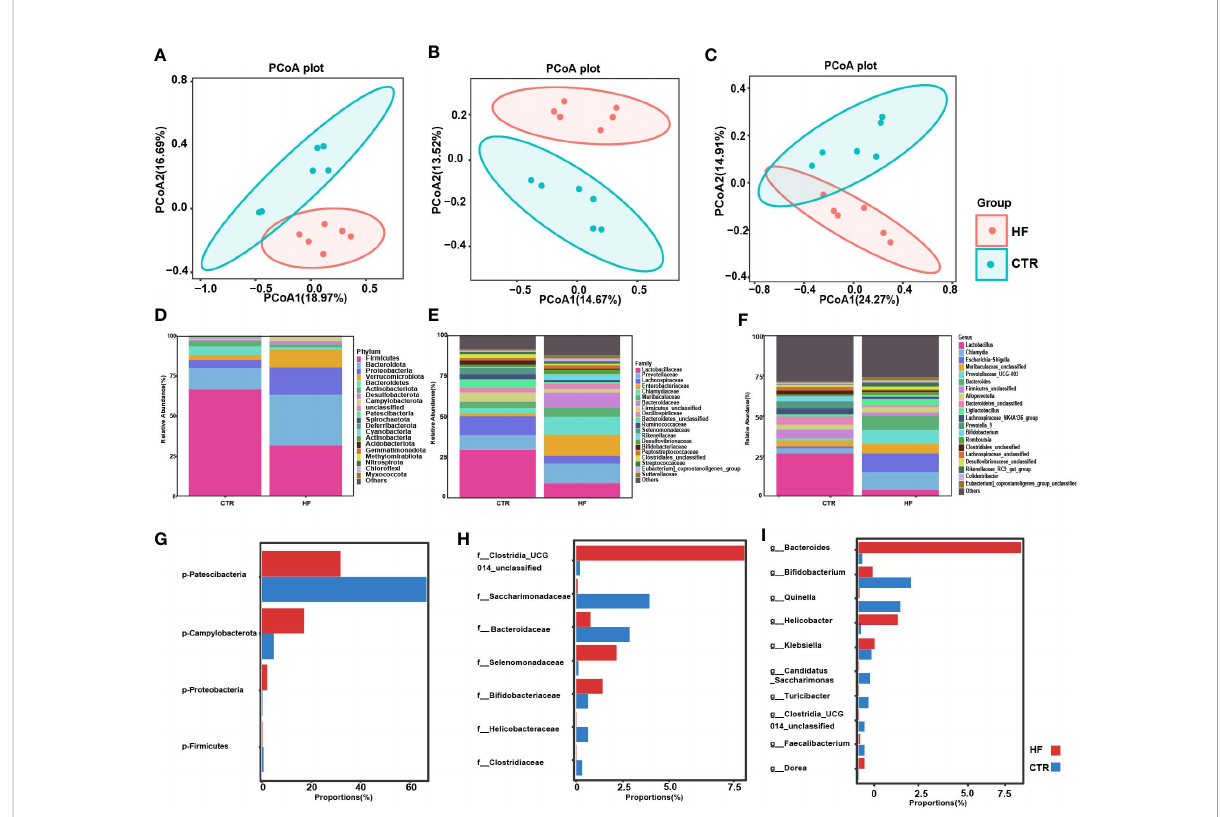
FIGURE 3 HFD alters gut microbiota in obesity-induced precocious puberty female rats. During postnatal day (PND) 21, female rats were fed a HFD and a normal diet until the rats were sacri fi ced during diestrus after completing the estrous cycle. Microbial 16S rDNA genes were subsequently sequenced. (A) PCoA plot of Bray-Curtis distance of the gut microbiota. (B) PCoA plot Jaccard distance of gut microbiota. (C) PCoA plot of unweighted Uni-Frac distance of gut microbiota. (D – F) Community composition distribution at the phylum, family and genus level. (G – I) The most differentially abundant proportions between the HF and CTR group at the phylum, family and genus levels. n=6 per group for gut microbiota analysis. Signi fi cance was tested with the Wilcoxon rank-sum